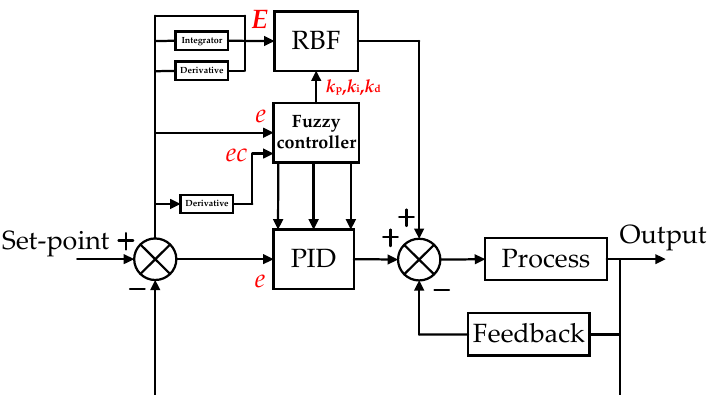
Figure 7. RBF compensation fuzzy PID controller (RFPID) control system. Note: RBF = radial basis function